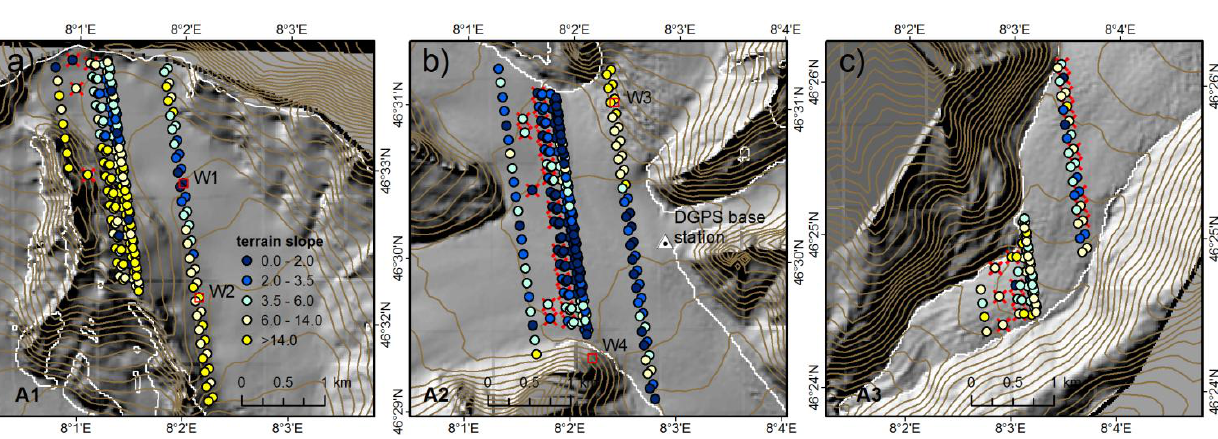
Figure 2. Terrain slope at ICESat points in the three areas A1 ( a ), A2 ( b ) and A3 ( c ) on the Grosser Aletschgletscher. Red crosses indicate canceled points with erroneous elevations due to cloud cover. Glacier outlines are from the Global Land Ice Measurements from Space (GLIMS) dataset. The red squares mark the points for which the waveforms are shown in